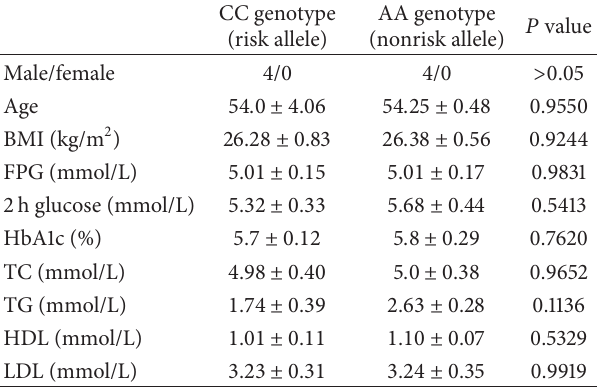
Table 1: Clinical characteristics of the four CC carriers and four AA carriers.